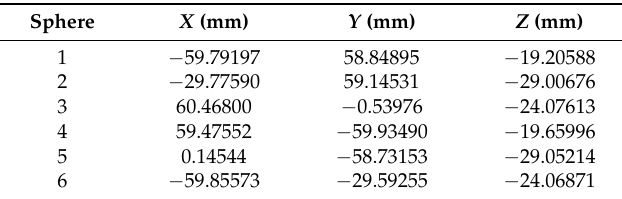
Figure 7. Measurement on a coordinate measuring machine (CMM) machine. Figure 8a shows the 3D measurement data and the designed surface with their added fiducials and the matching result after positioning the measured points using the FAPM as shown in Figure 8b. According to the 3D form deviation, the evaluated surface error in terms of PV value was about 20.7 μ m, while that for the RMS value was approximately 2.21 μ m. Figure 8. ( a ) FA-CAD and fiducial-aided measured surface (FA-MS); ( b ) 3D form error evaluation. In addition, the LSM was also employed to obtain the form errors as shown in Figure 9. It was found that the PV value and RMS value were slightly larger than those resulting from the FAPM, with 29.2 μ m and 2.5 μ m, respectively.